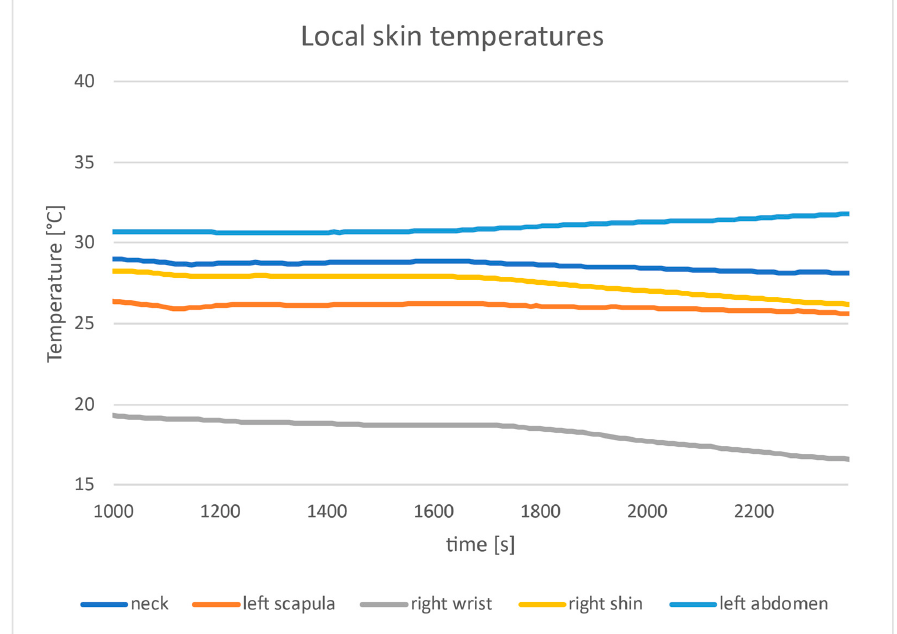
Figure 10. Local skin temperatures for participant B when adjusting to reach subjective thermal comfort.